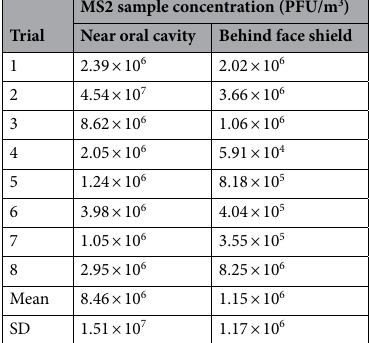
Table 1. MS2 viral concentration (PFU/m 3 ) sampled across all trials. The arithmetic mean and standard deviation for each column are provided at the bottom of the table.